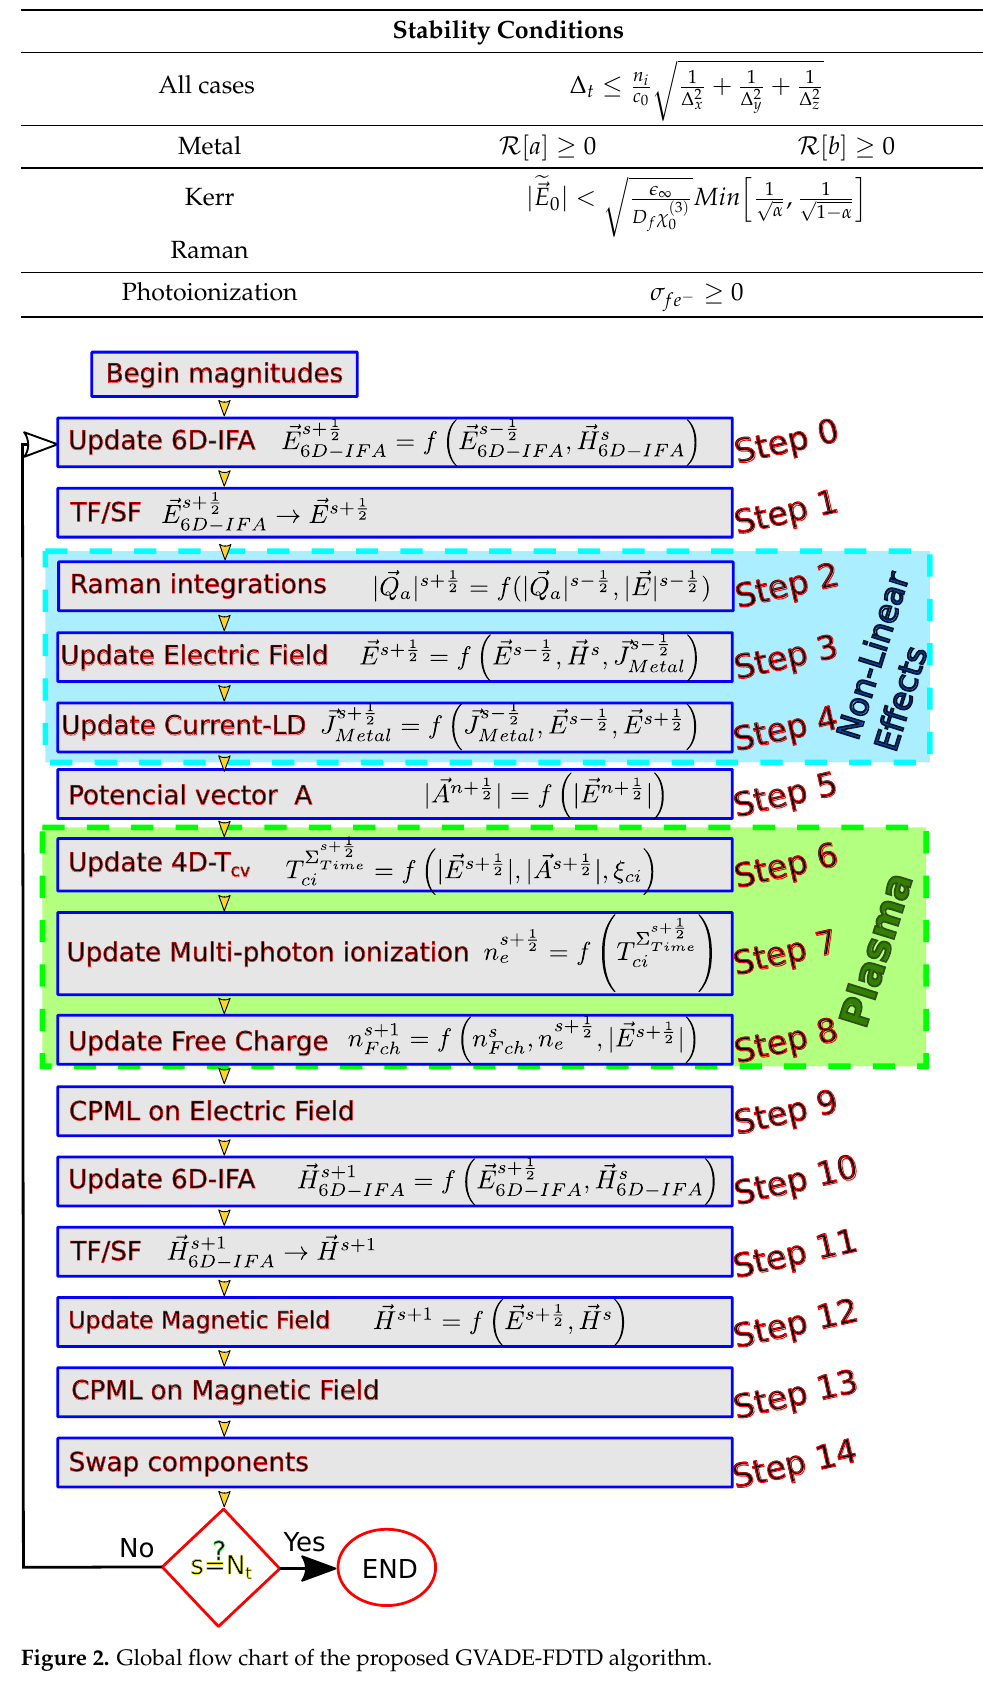
Table 2. List of stability conditions. Note that Min [] selects the minimum value in a list.